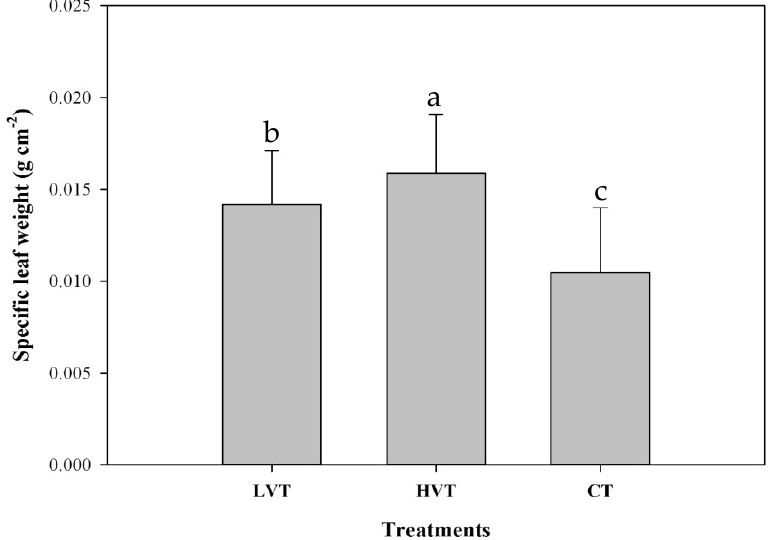
Figure 11. The average leaf specific weight for strawberry for each treatment. Means followed by the same letter are not significantly different ( p < 0.05, Scheffé test). LVT is the low-temperature oscillation pattern, HVT is the high-temperature oscillation pattern, and CT is the fixed temperature